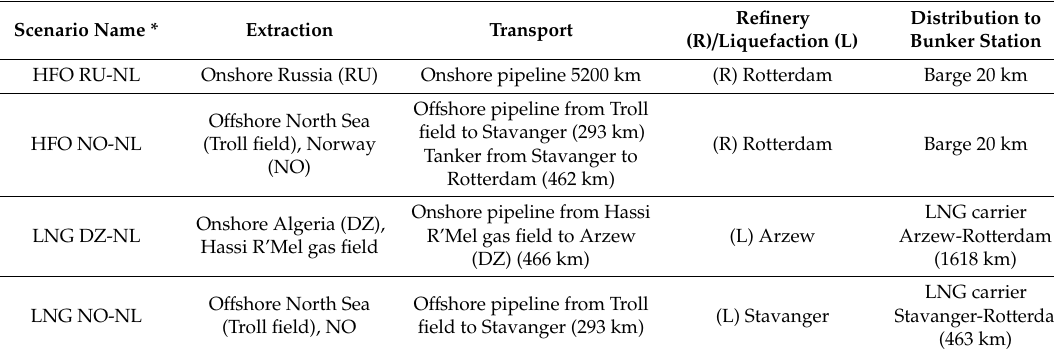
Table 3. Specification of geographical